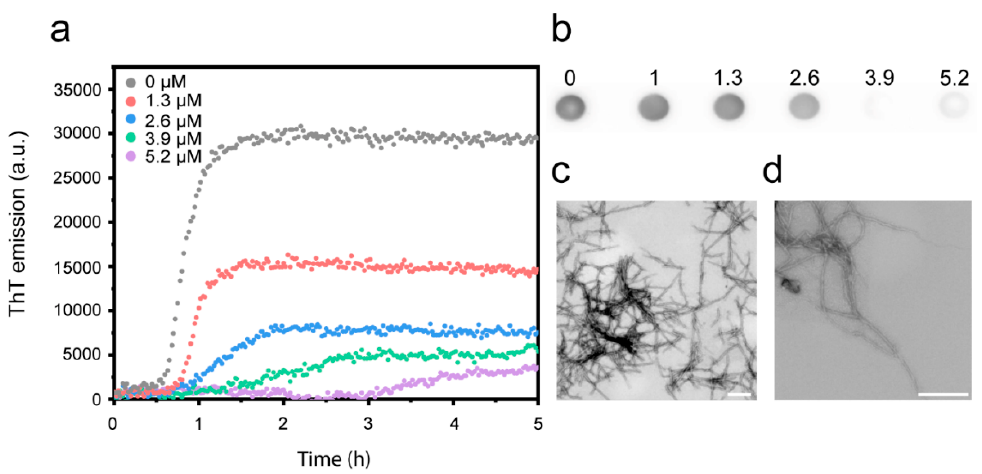
Figure 2. A β (1-42) amyloid formation at pH 8.0 in the presence of Cu 2 + . ( a ) Amyloid formation kinetics of 2.6 µ M A β (1-42) measured by thioflavin-T (ThT) (5 µ M) fluorescence in the presence of indicated concentrations of CuCl 2 . Data are shown as representative curves; the full set of replicates (n = 3) are shown in Figure S2a. ( b ) Dot blot showing LOC-positive A β (1-42) species at the endpoint of the kinetic experiments shown in ( a ). The full, uncropped image of the dot-blot membrane is shown in Figure S4. ( c , d ) TEM images of 2.6 µ M A β (1-42) amyloid fibrils formed in the presence of ( c ) 1.3 µ M and ( d ) 5.2 µ M Cu 2 + . The scale bars represent 200 nm.